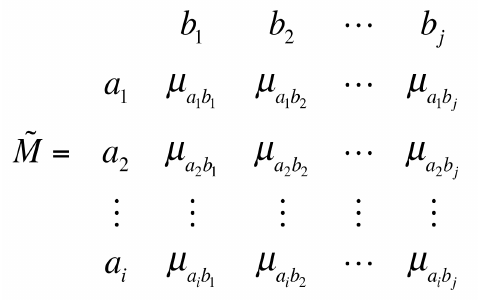
Figure 2. Direct Incident